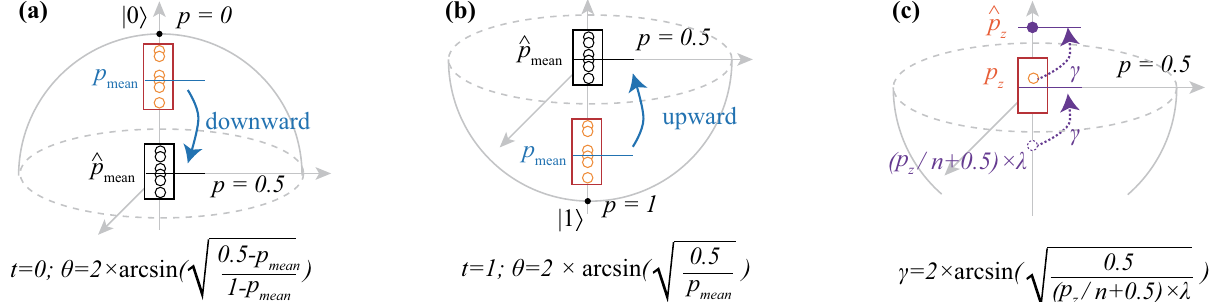
Fig. 5 QF-FB: the determination of parameters, t , θ , and γ , in batch normalization component of QF-Nets. a Batch_adj when t = 1; b batch_adj when t = 0; c